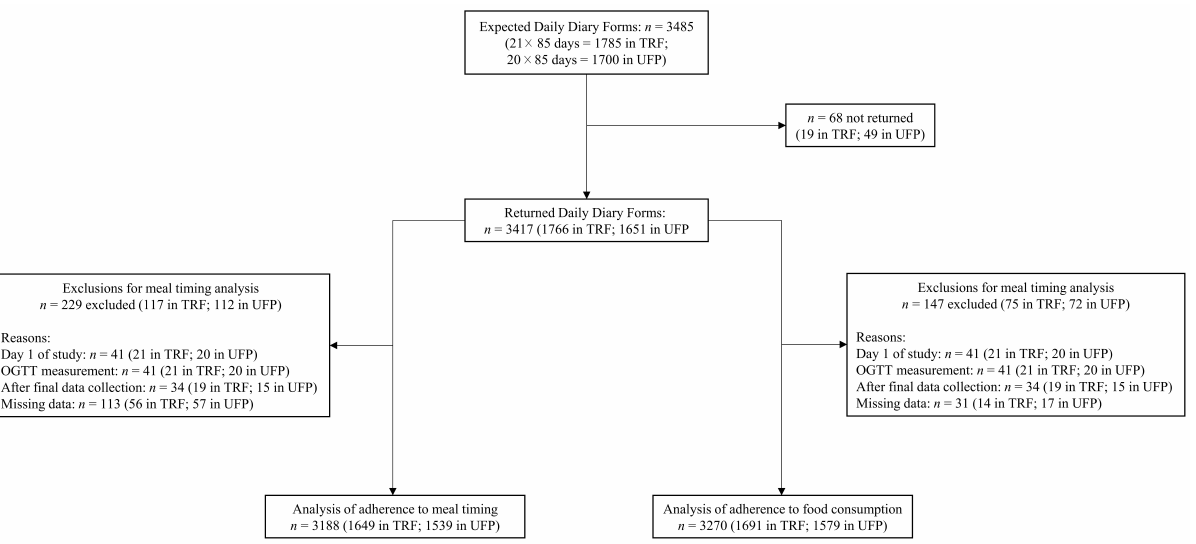
Figure A3. Flowchart showing the process of inclusion and exclusion of daily diary forms in the